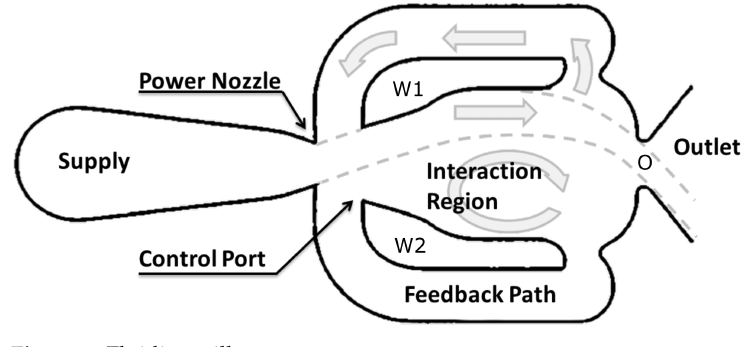
Figure 1. Fluidic